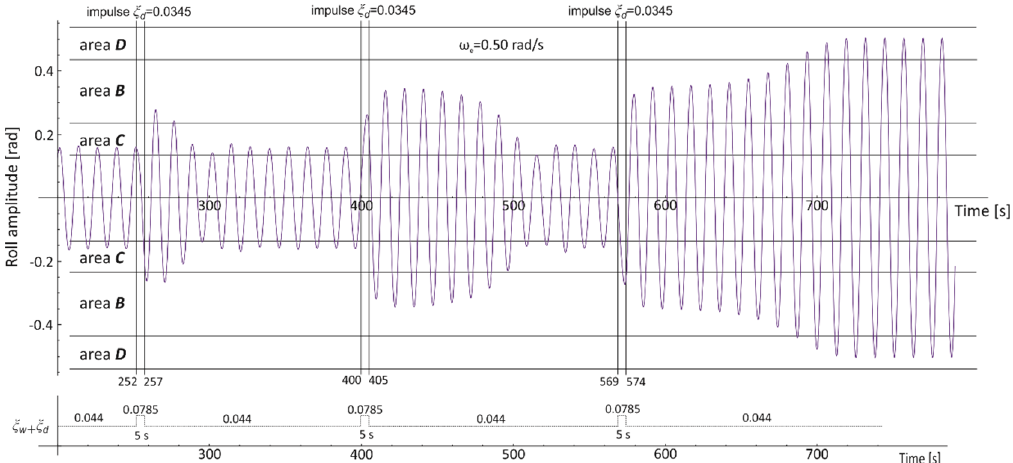
Figure 11. Roll time history for the OSV vessel ( T = 6.10 m, GM 0 = 2.50 m, ξ w = 0.044). The additional exciting moments: ξ d 1 (252–257 s) = ξ d 2 (400–405 s) = ξ d 3 (569–574 s) = 0.0345.